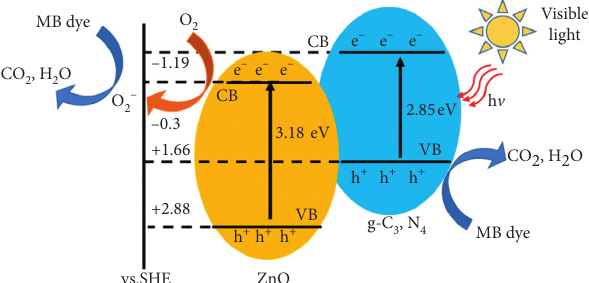
Figure 8: Simplified schematic diagram of the energy band structure and electron-hole pair separation in g-C 3 N 4 @ZnO